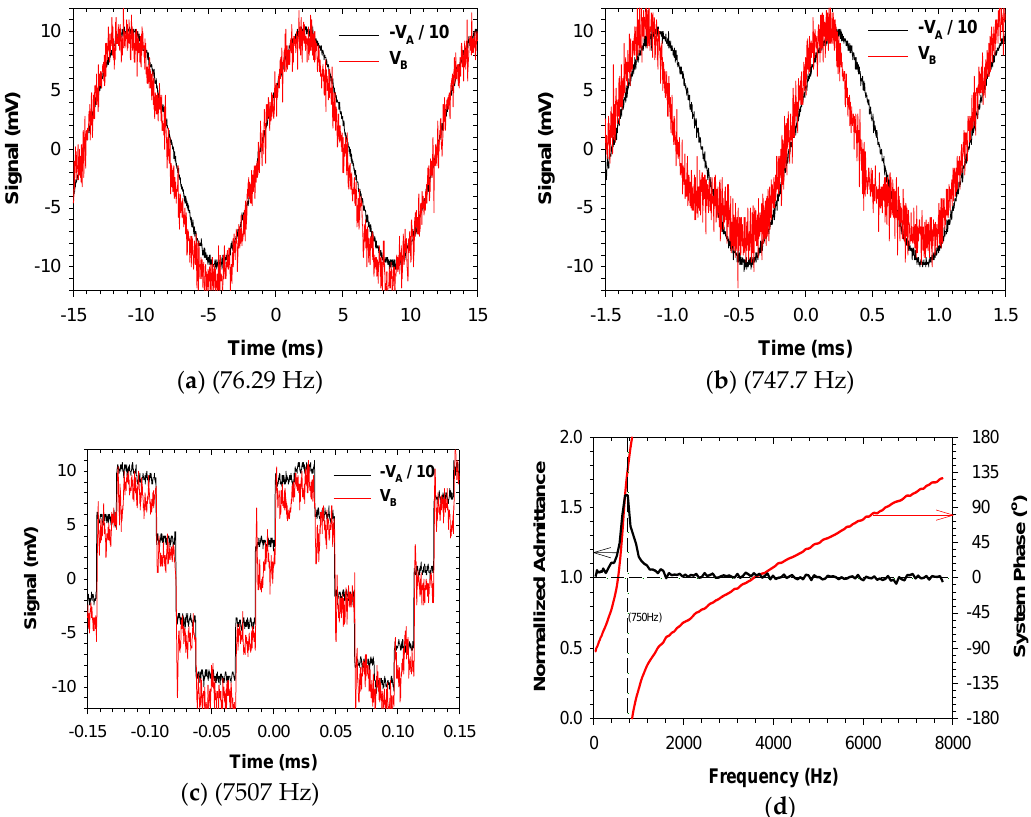
Figure 7. Recorded signals from digital synthesizer of network analyzer (V A ) and output of summing junction (V B ) for potentiostat operating to deliver 10 mV peak at ( a ) 76.29 Hz; ( b ) 747.7 Hz,